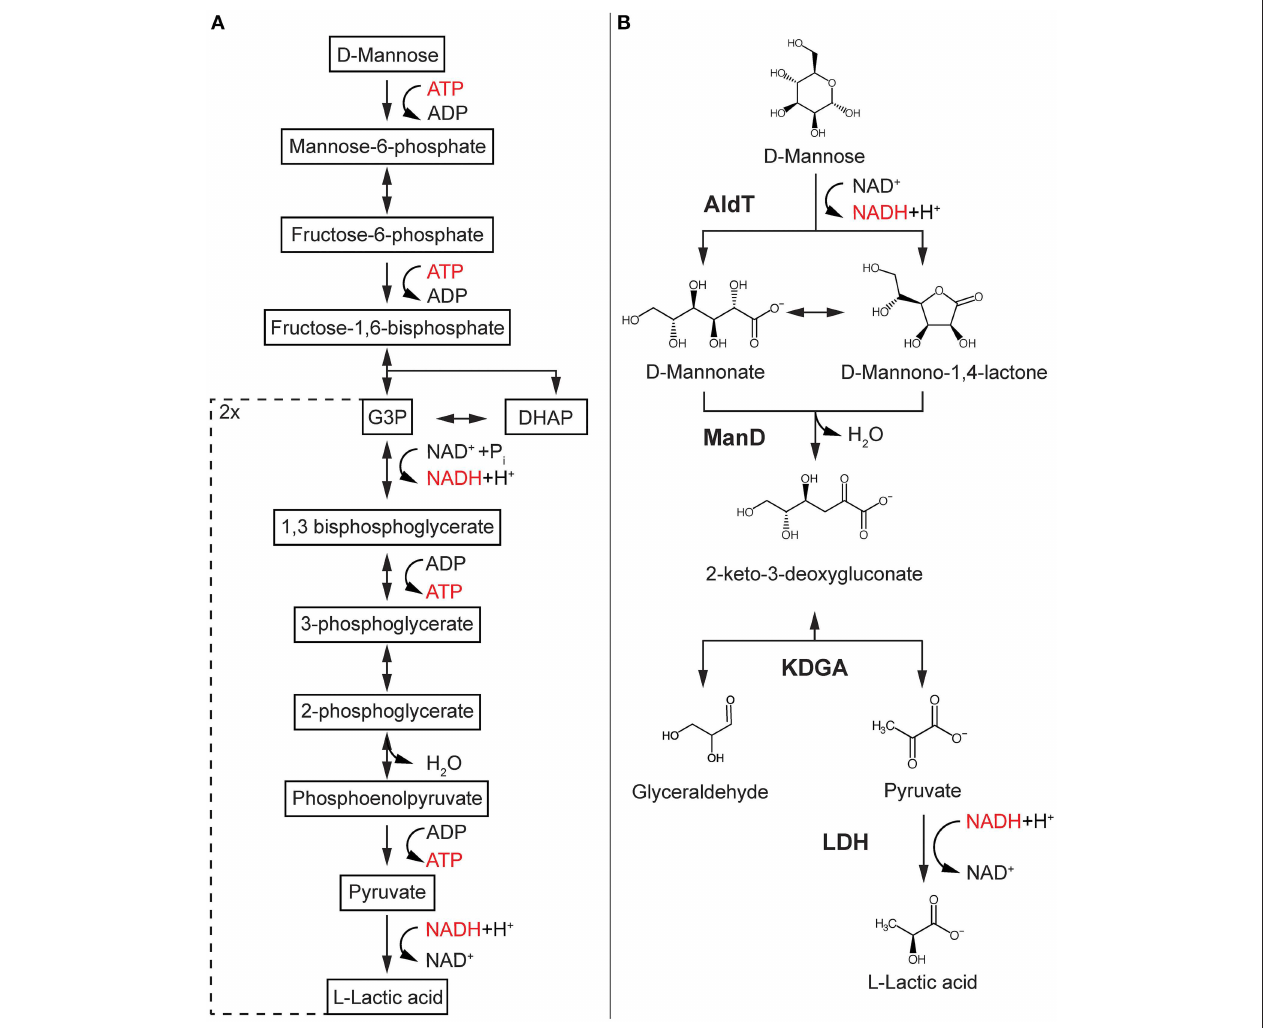
FIGURE 1 | Glycolysis-based mannose pathway and the designed synthetic reaction cascade. EMP-based pathway found in most production hosts such as S. cerevisiae (A) compared to synthetic reaction cascade for cell-free conversion of mannose into LA (B) . Enzymes are in bold, reduced cofactor in red. AldT, aldohexose dehydrogenase; ManD, mannonate dehydratase; KDGA, 2-keto-3-deoxygluconate aldolase; LDH, lactate dehydrogenase; G3P, glyceraldehyde-3-phosphate; DHAP, dihydroacetone phosphate.